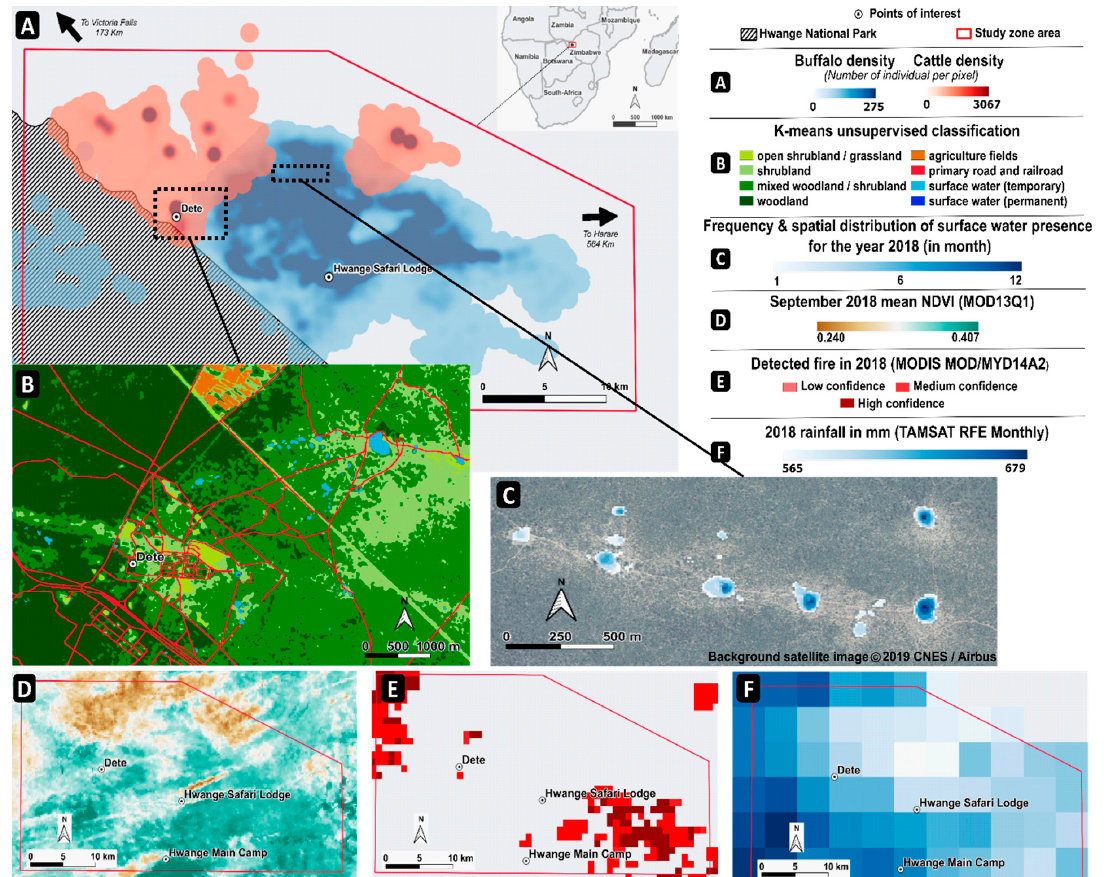
Figure 3. Illustrative examples of SRS-derived environmental drivers of buffalo and cattle movement in HNP, Zimbabwe (refer to supplementary materials for a complete description of the data used).